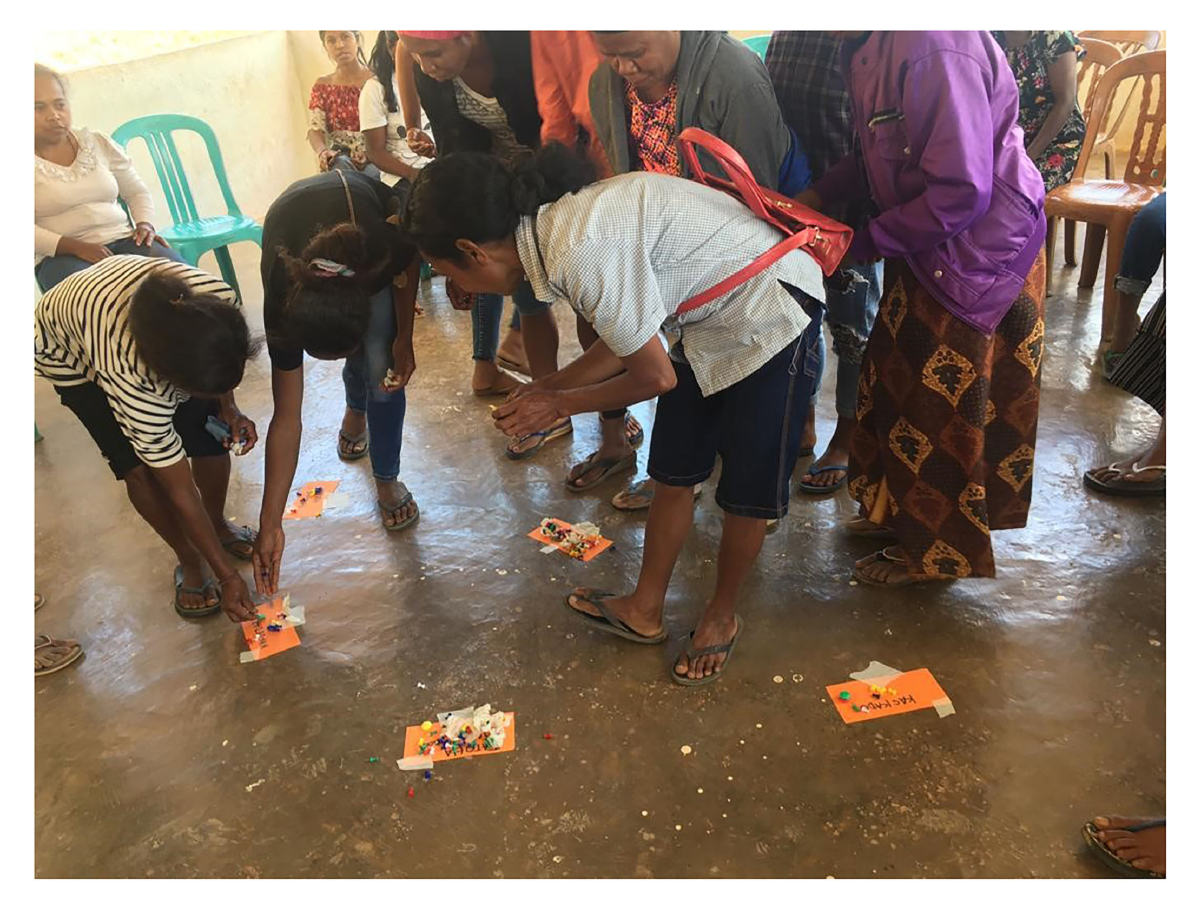
FIGURE2 Women’s focus group doing disease ranking exercise at Gildapil